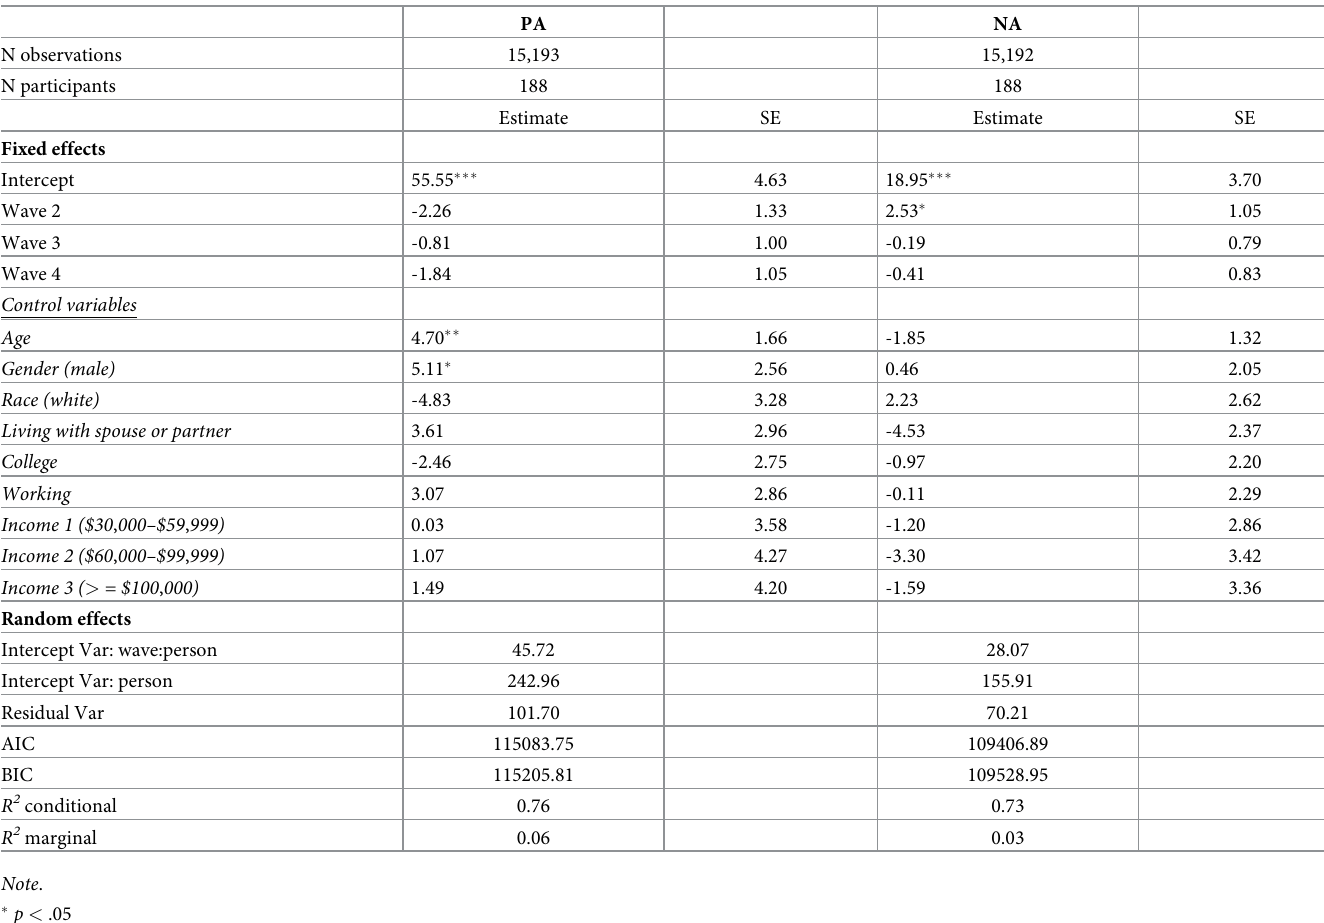
Table 3. Multilevel models with wave and demographic variables predicting PA and